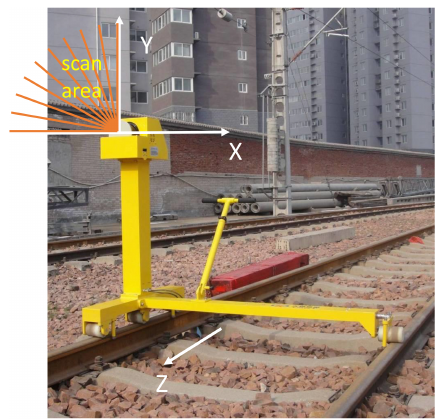
Figure 2. Data collection equipment and coordinate system.